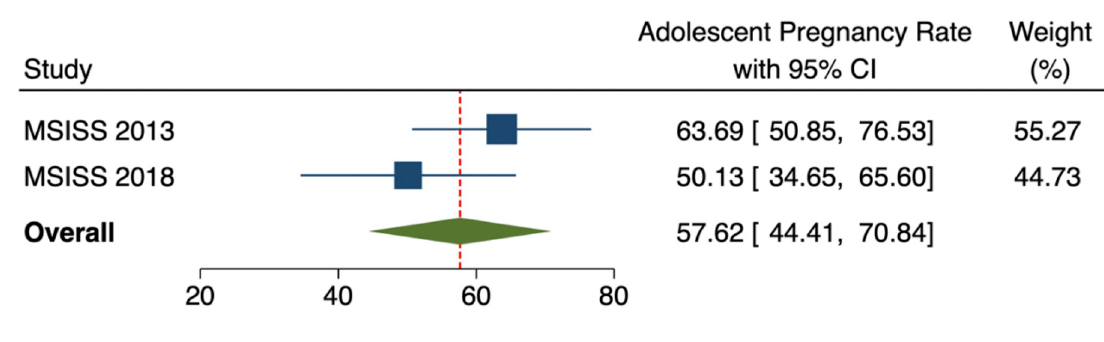
Fig 3. Adolescent pregnancy in Mongolia,